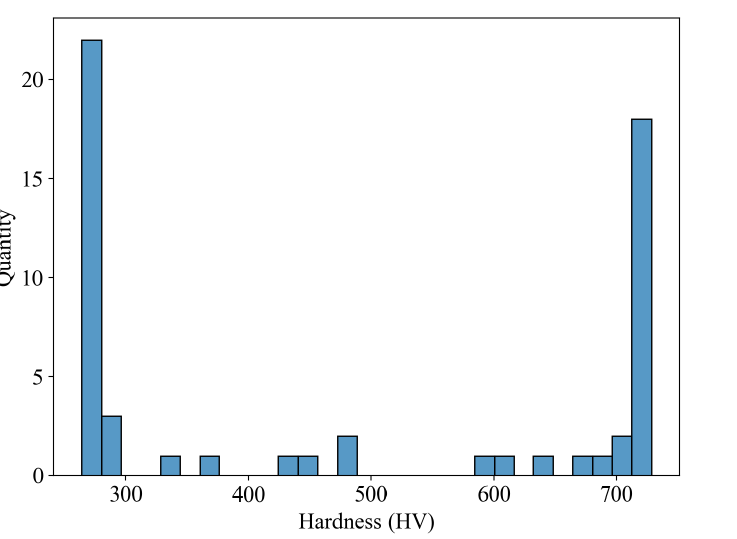
Figure 11. Hardness points histogram of the data located in the area of the sensor 2 (Figure